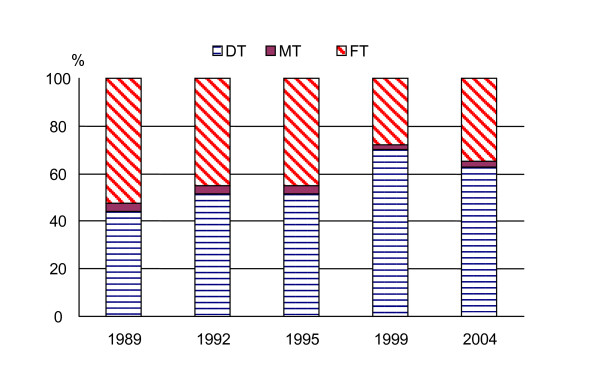
Variation of DT, MT and FT components in DMFT index.